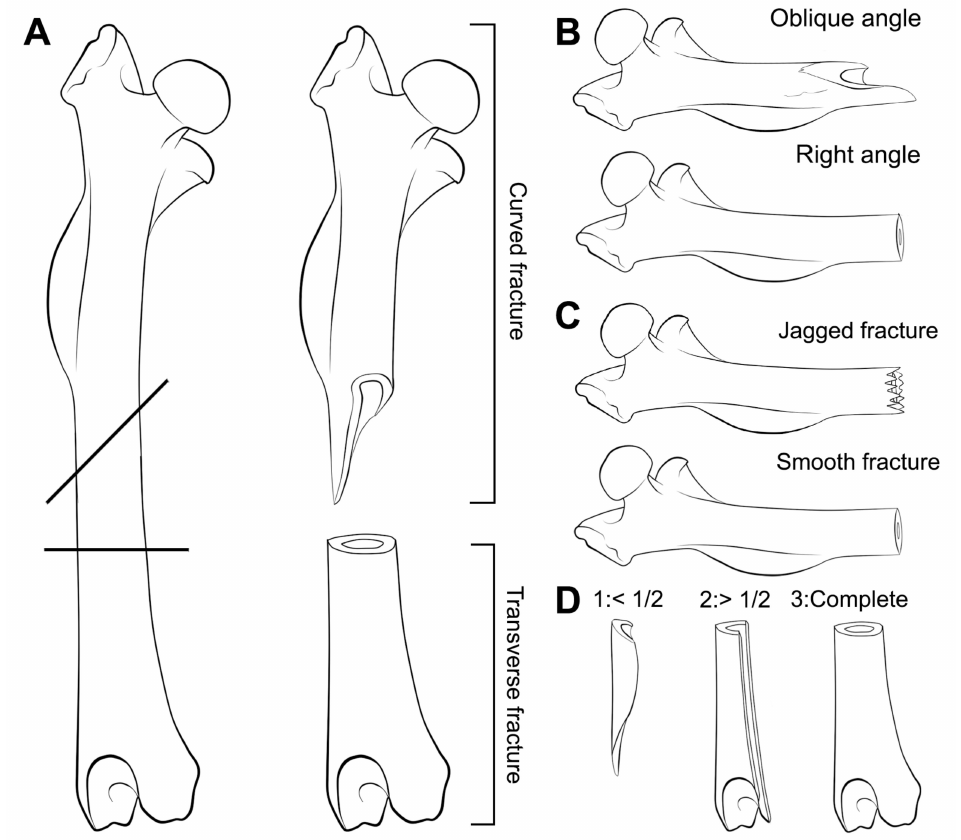
Figure 3. Scheme for the different fractures proposed by Villa and Mahieu [17] modified and applied to small mammals for a descriptive approach. ( A ) Fracture outline; ( B ) Fracture angle; ( C ) Fracture edge; ( D ) Completeness of the